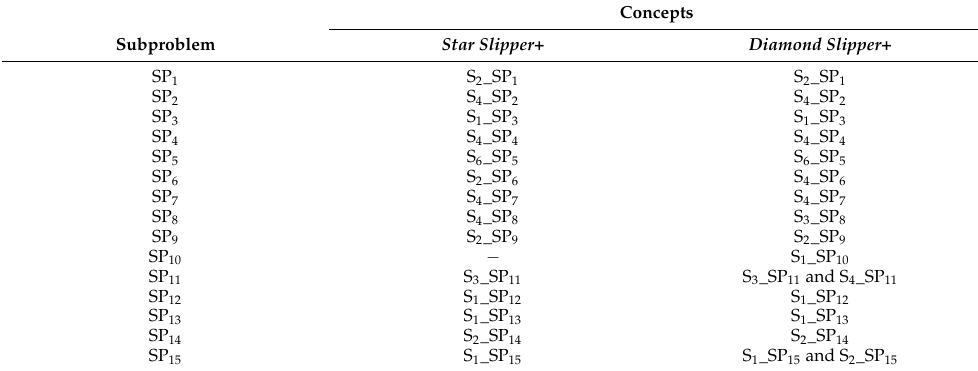
Table 16. New concepts generated by the combination of solutions.